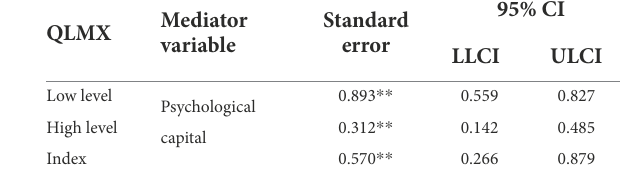
TABLE 3 Moderated mediating effect.